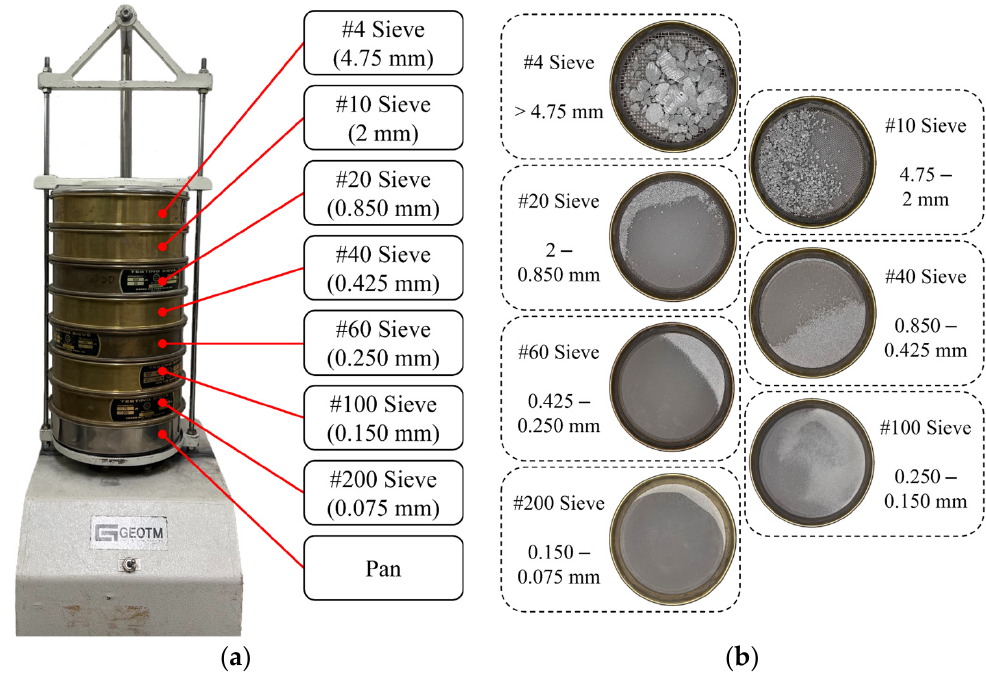
Figure 5. Sieving machine and example of rock chips after sieving: ( a ) number and opening size of sieves; ( b ) example of rock chips classified by size range ( p = 9 mm and s = 48 mm at UCS = 40 MPa).